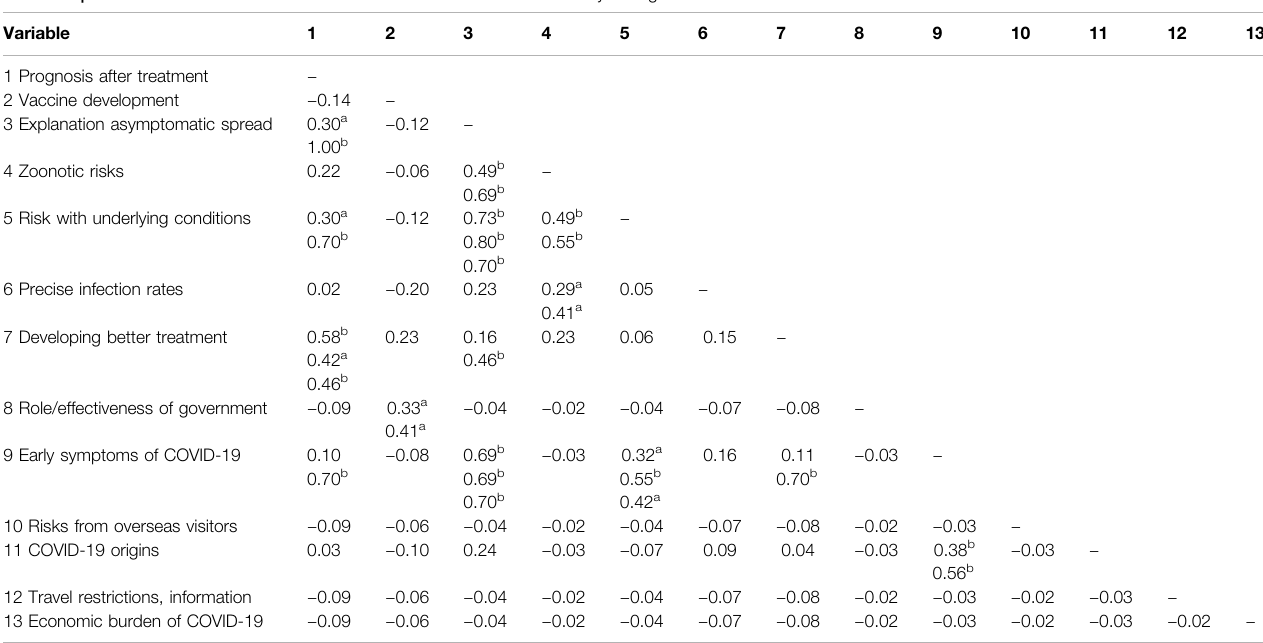
TABLE 7 | Combined RoK and Vietnam correlations on information insuf fi ciency during COVID-19.